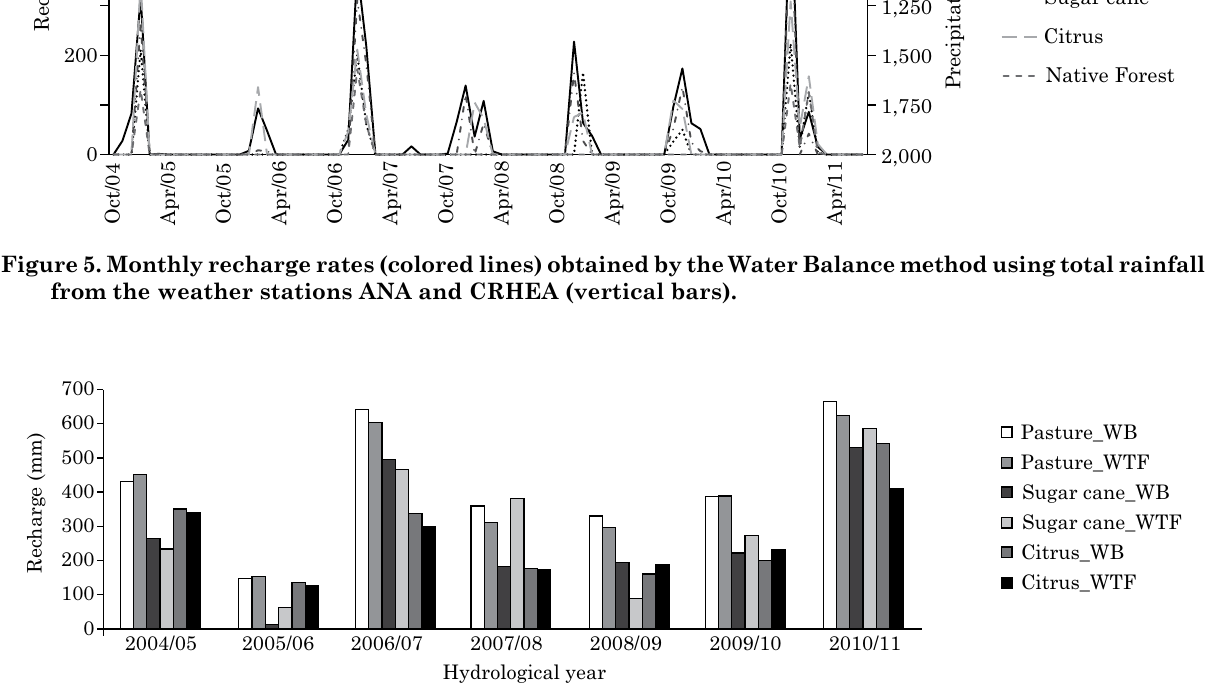
figure 6. comparison between y the annual recharge rates obtained by the water Balance and water table fluctuation (wtf) methods.